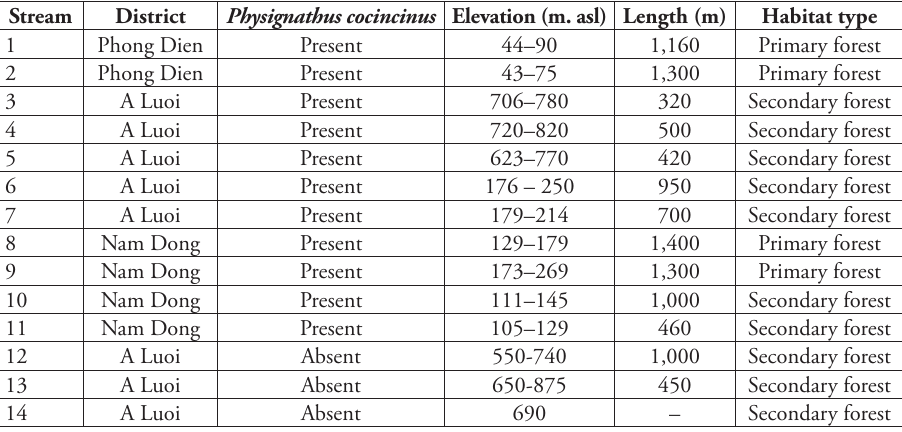
Table 1. Survey sites in Thua Thien Hue Province, central Vietnam.